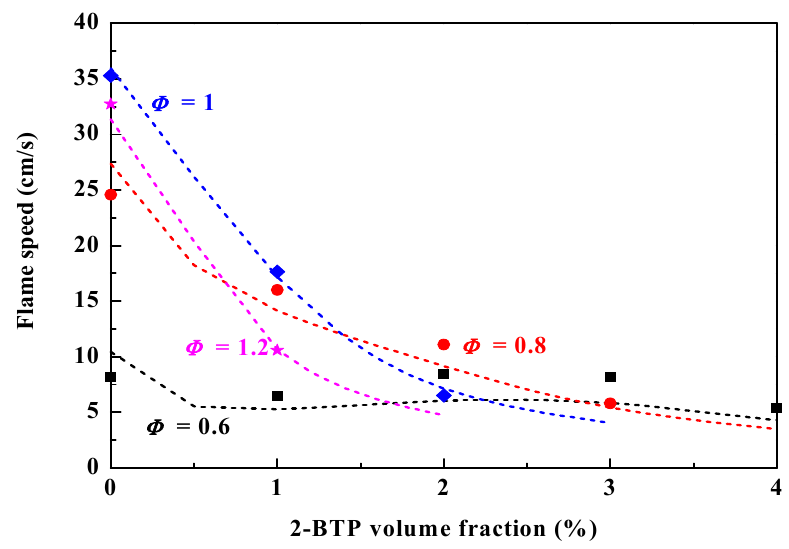
Figure 1. The measured [8] and calculated laminar flame speed of CH 4 /air mixtures at Φ = 0.6, 0.8, 1.0 and 1.2 with different 2-BTP additions at 298 K and 1 bar.